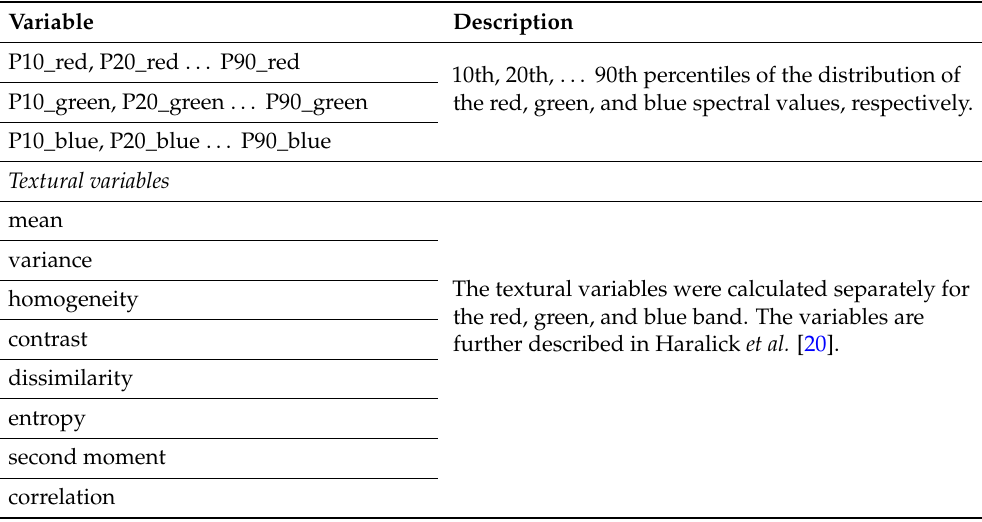
Table 2. Variables derived per plot from the orthophotos.